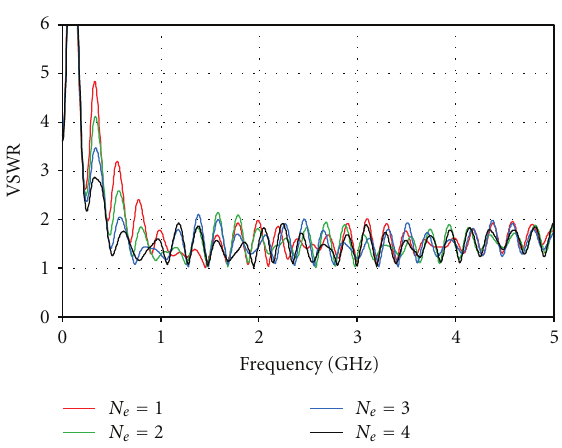
Figure 4: Comparison of return losses of the TEM-wire parabola with N e = 1, 2, 3, and 4.